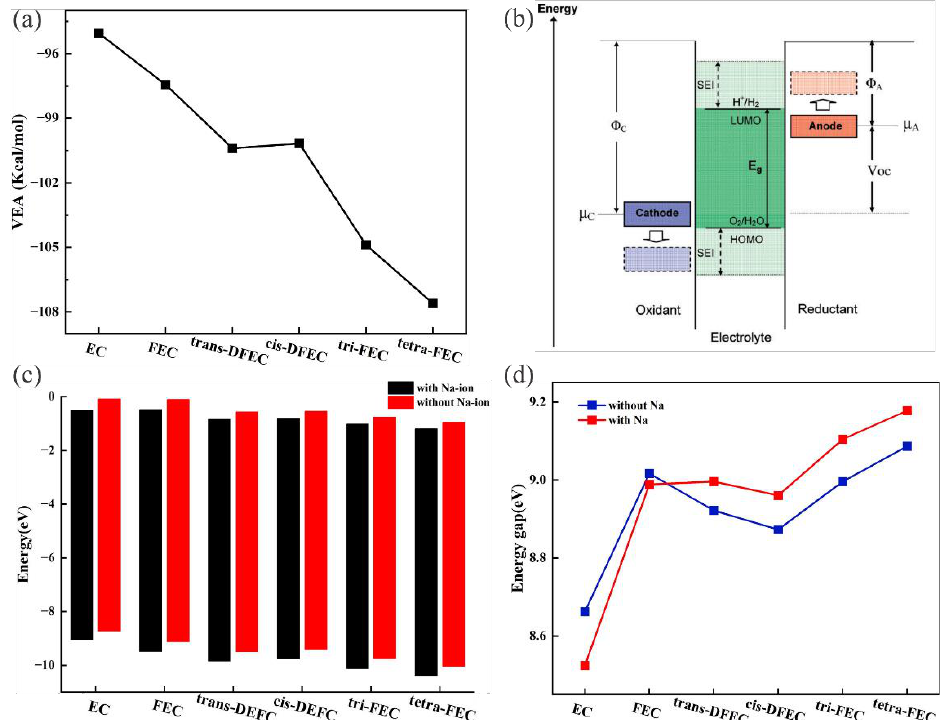
Figure 2. Vertical electron affinity (VEA) of EC and fluorinated EC ( a ). Schematic of ESW ( b ), Φ A and Φ C are the anode and cathode work functions, E g is the ESW [4]. HOMO – LUMO of EC and fluorinated EC when Na-ion were added ( c ). HOMO – LUMO energy gap of EC and fluorinated EC when Na-ion were added ( d ).